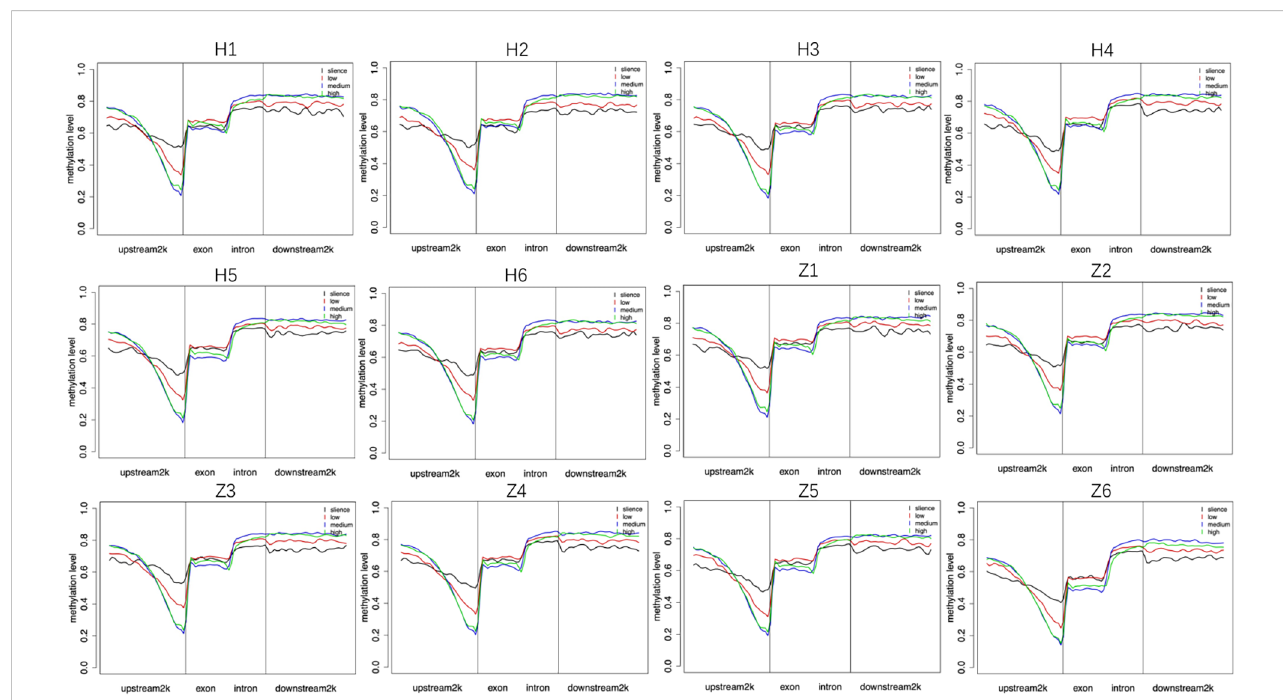
FIGURE 6 Relationship between DNA methylation and gene expression. Silence (RPKM=0), low: low expression (0<RPKM ≤ 1), medium: medium expression (1<RPKM ≤ 10), high: high expression (RPKM>10). H: Han, Z: